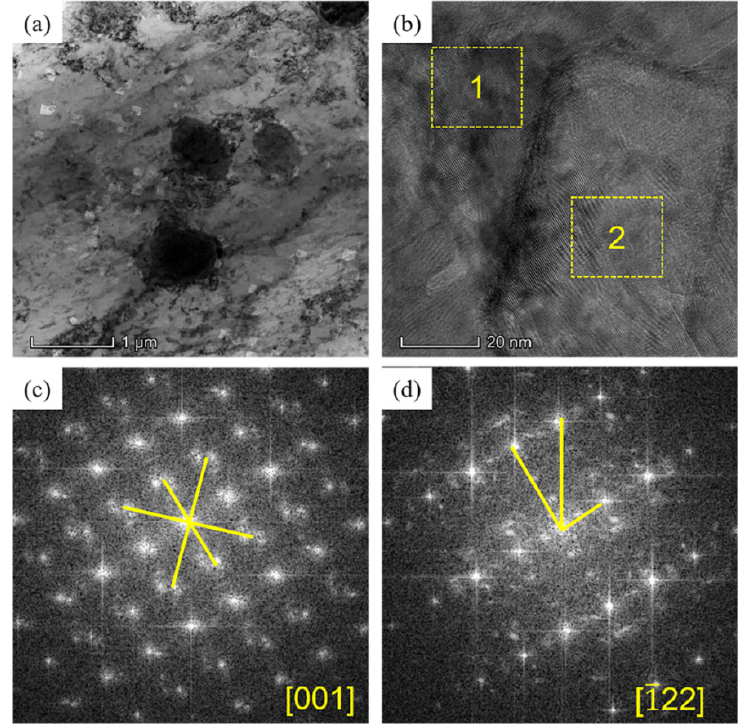
Figure 4. ( a ) TEM image and ( b ) HRTEM image of spinodal decomposition organization in the as-cast LAZ1366 alloy; FFT results of ( c ) area 1 and ( d ) area 2 in ( b ).